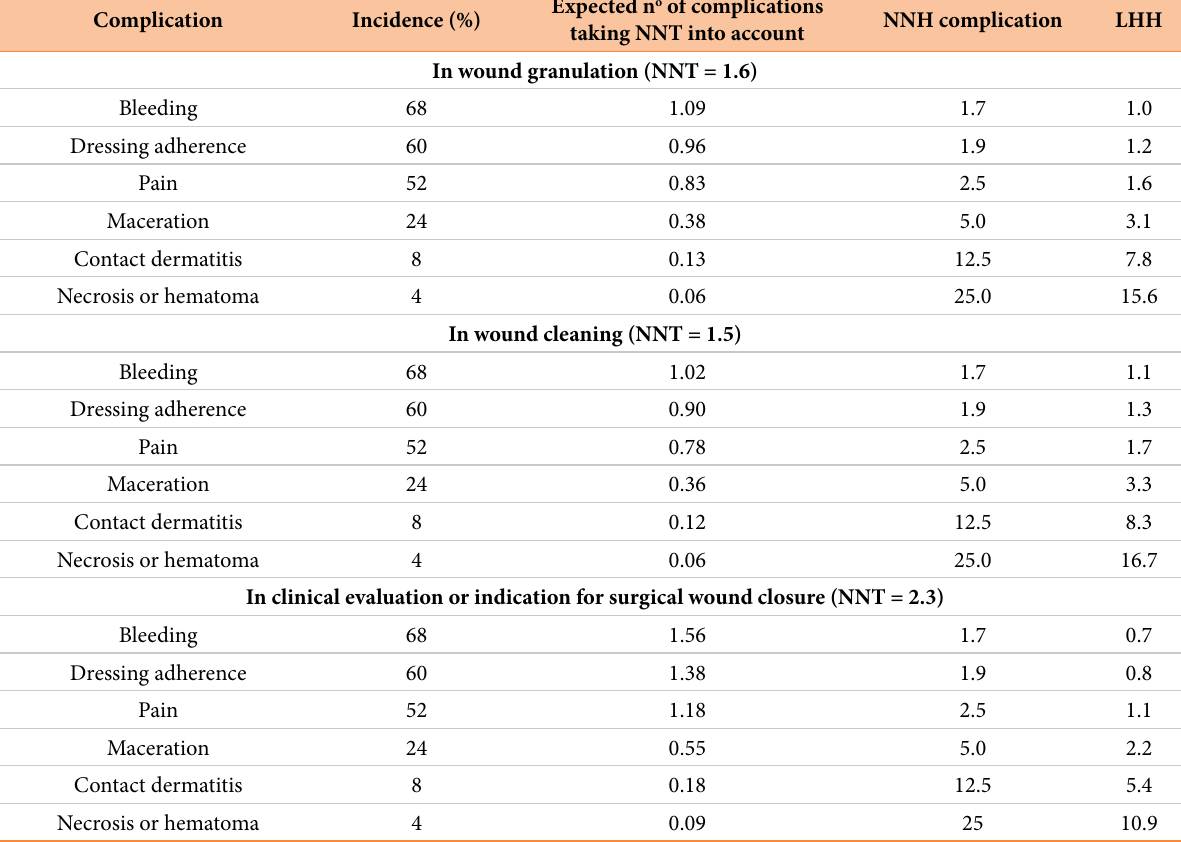
Table 6 - Efficacy vs. adverse effect for SVDM in granulation, cleaning, clinical evaluation, and indication for surgical wound closure: chance of benefit or harm